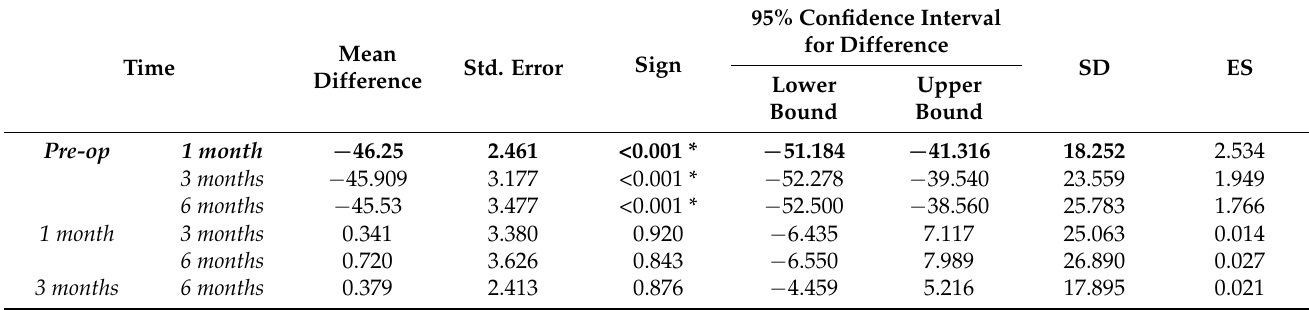
Table 4. Responsiveness of FJS-12 over time.